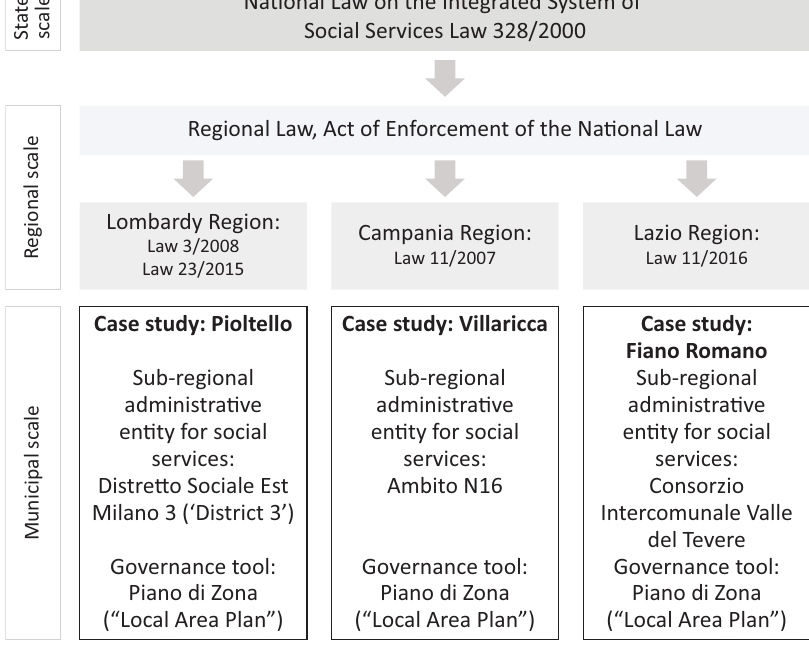
Figure 2. The scheme of welfare governance in Italy, with relevant details referring to the three case studies. the municipalities of Segrate, Rodano, Vimodrone,